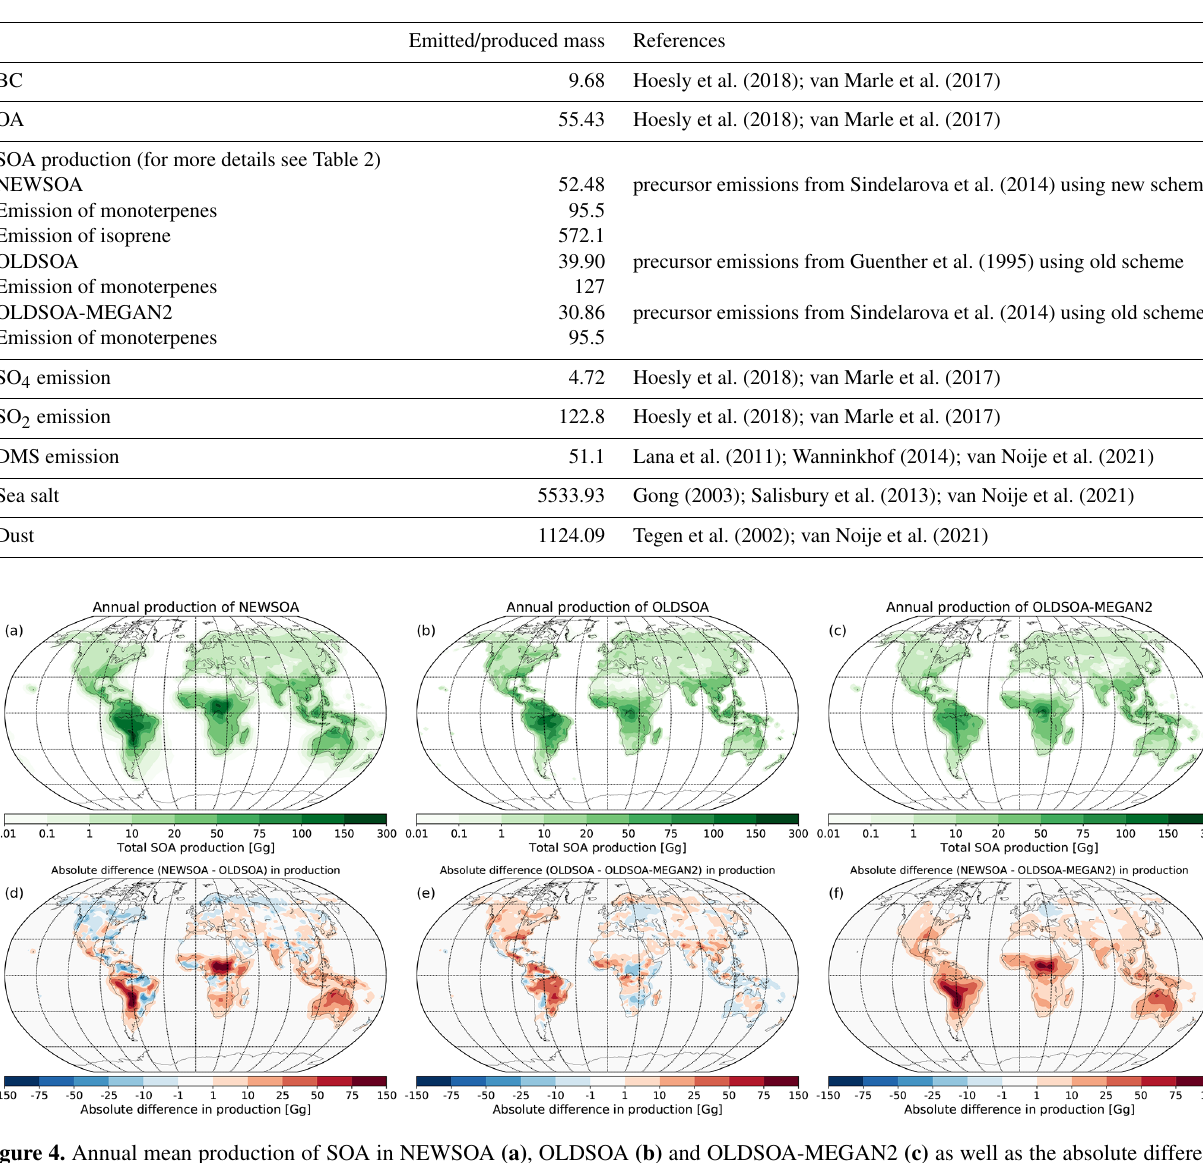
spatially different emissions of monoterpenes in MEGANv1 compared to MEGANv2.1 as stated earlier (see Fig.